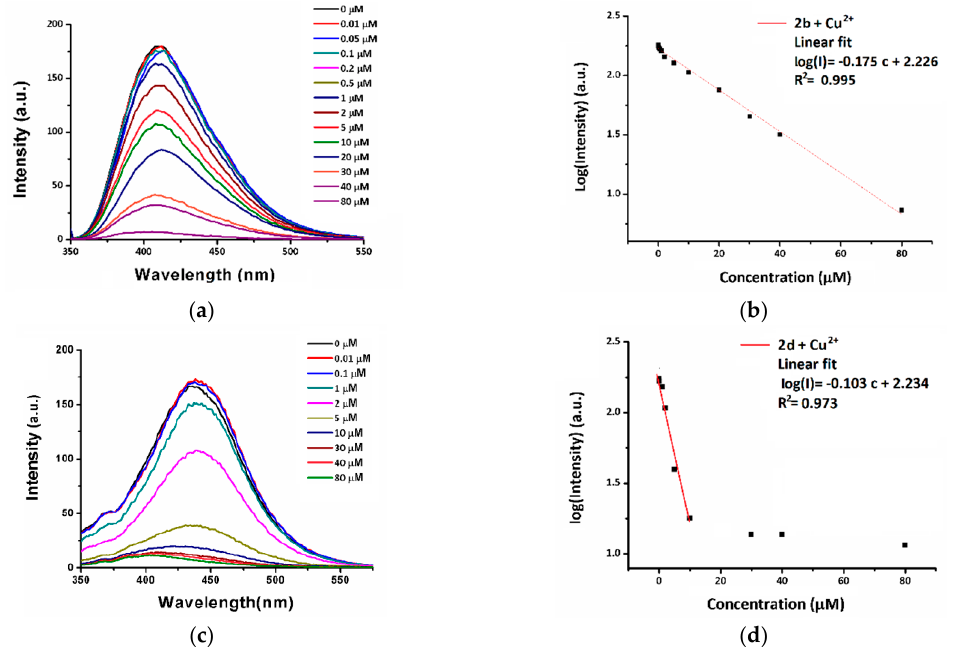
Figure 3. Fluorescence spectra of ( a ) 2b ( λ ex = 303 nm) and ( c ) 2d ( λ ex = 325 nm) (30 µ M) with the addition of various concentrations of CuCl 2 in HEPES/DMSO buffer and the corresponding titration curves and linear ranges of ( b ) 2b and ( d ) 2d.